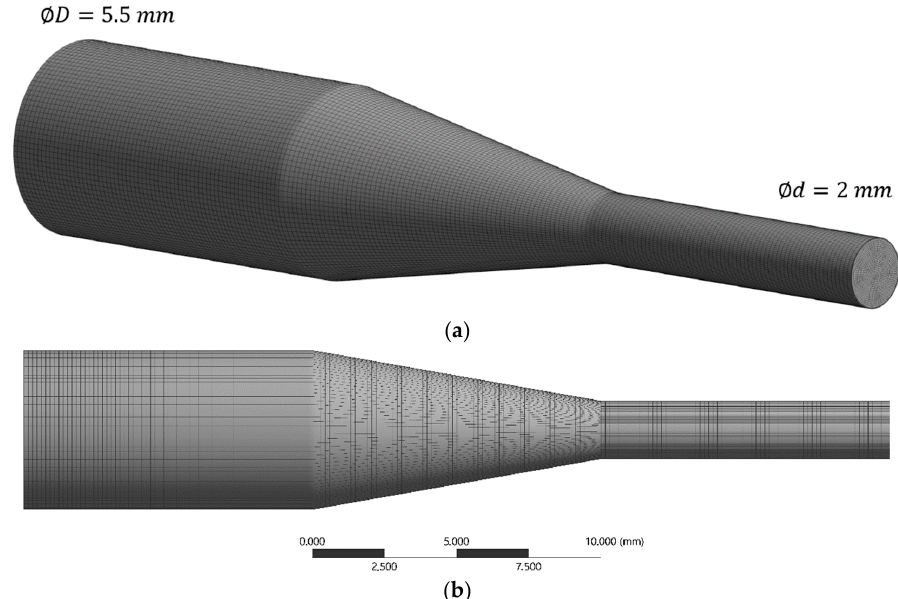
Figure 8. Numerical mesh of the investigated flow domain with three different tube sections in ( a ) axonometric view and ( b ) side view.